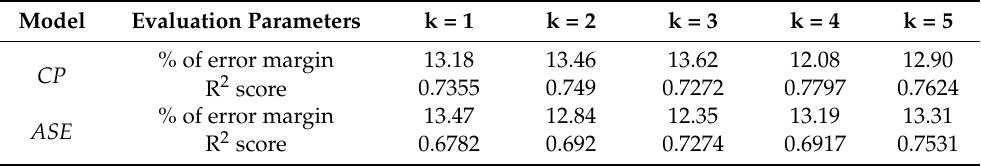
Table 4. 5-fold cross validation evaluation results.